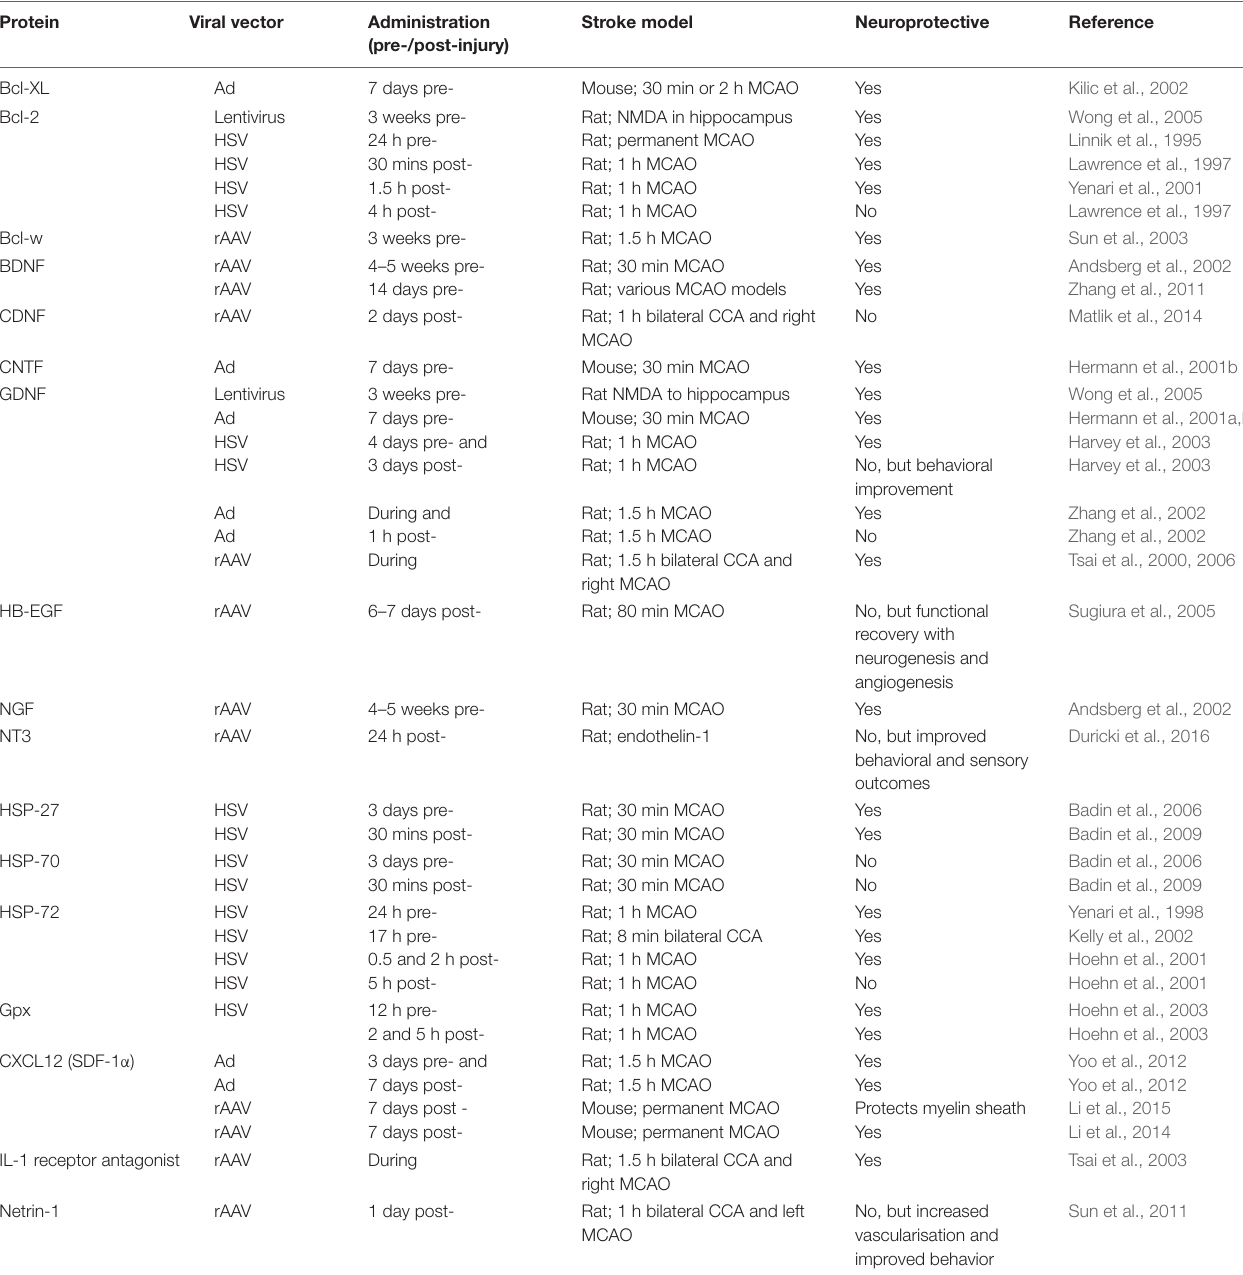
TABLE 1 | Viral gene delivery in animal models of